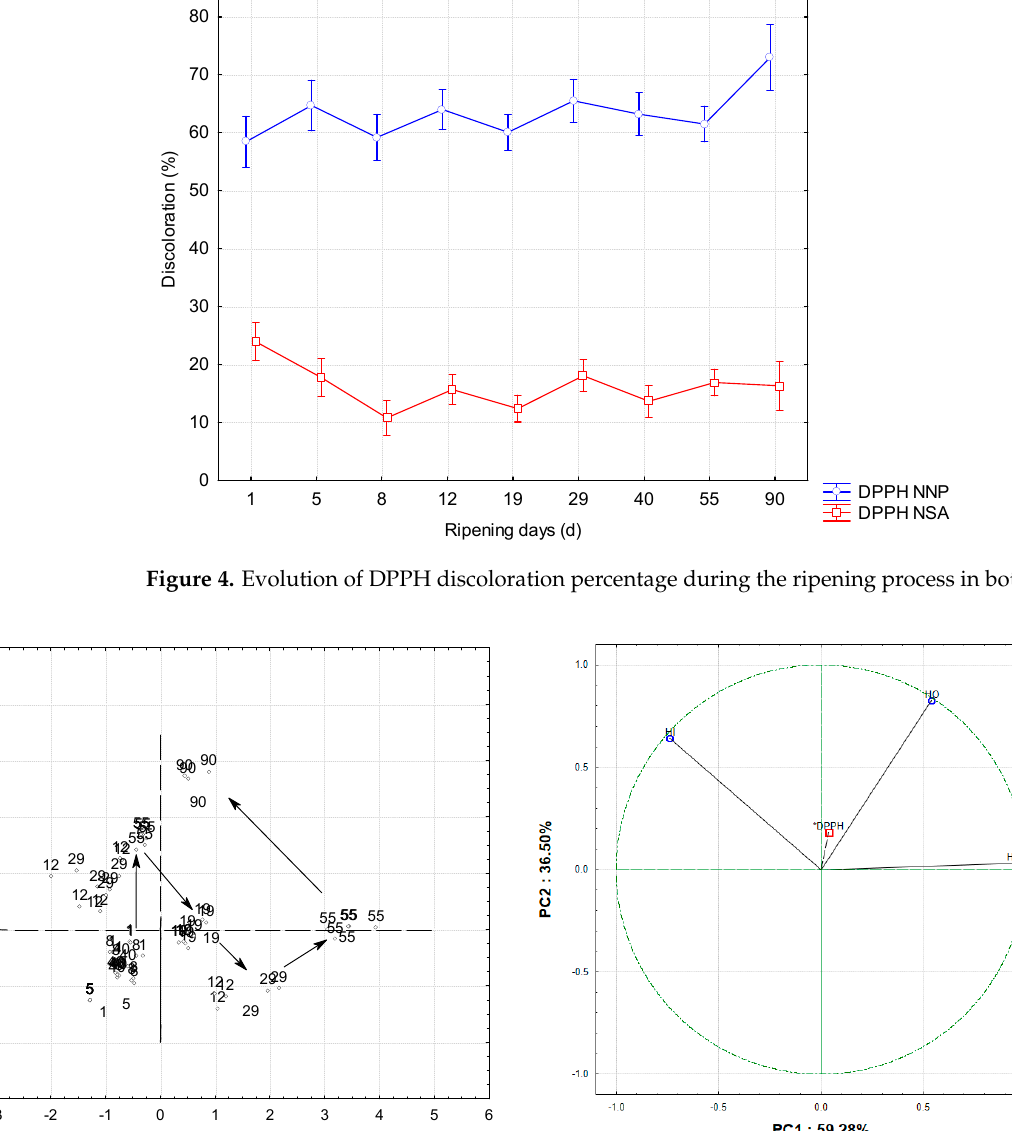
Figure 4. Evolution of DPPH discoloration percentage during the ripening process in both fractions.